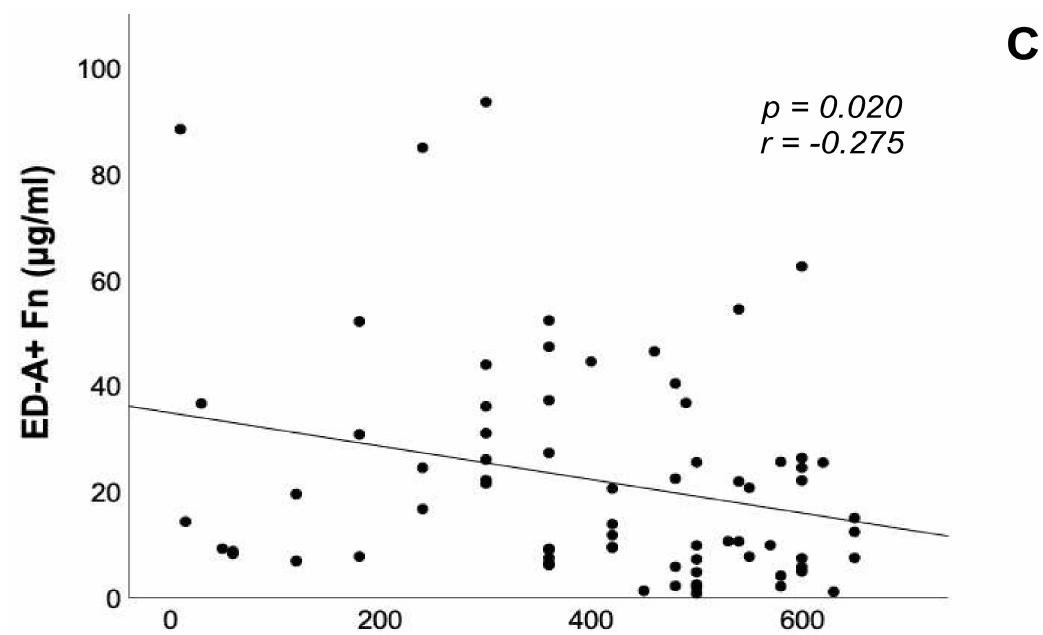
Figure 3. Correlation analyses between the serum concentration of ED-A + Fn and serum brain natriuretic peptide levels, 6-minute walk distance as well as systolic pulmonary artery pressure assessed by echocardiography. The correlation analysis graphs demonstrate significant correlations between ED-A + Fn and serum BNP levels ( A ), PAPsys ( B ) as well as SMWD ( C ). BNP: brain natriuretic peptide, PAPsys: systolic pulmonary arterial pressure, SMWD: 6-minute walk distance, Fn: fibronectin, p -value: level of significance, r-value: correlation